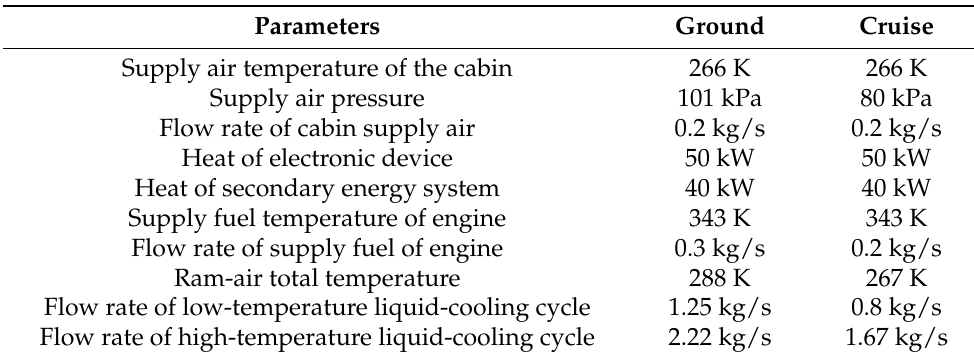
Table 1. Design parameters of